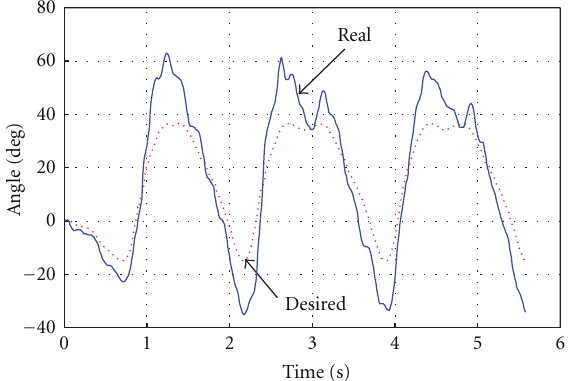
Figure 14: Real and desired hip joint angle of bionic leg during